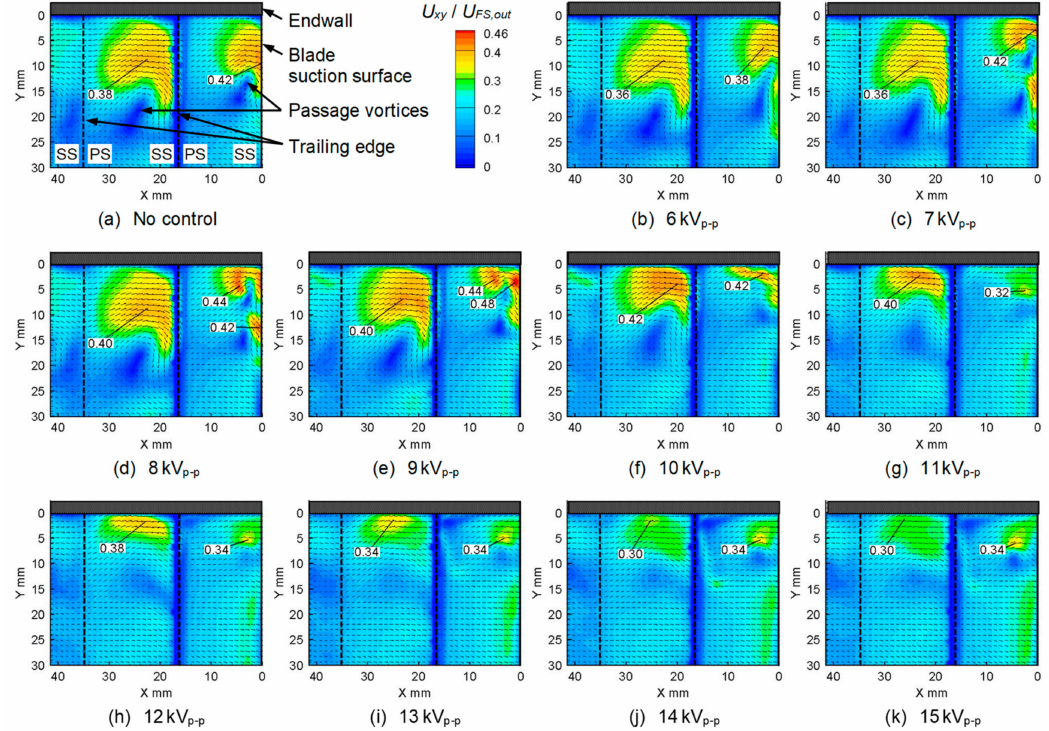
Figure 16. Velocity distributions at the outlet of the linear turbine cascade at various input voltages ( U FS , out = 4.7 m /